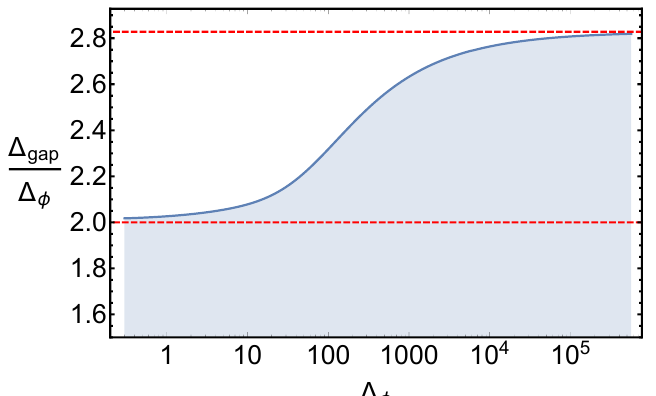
Figure 5 . Gap maximization with 100 components. The curve provides a valid upper bound on the dimension of (cid:30) 2 in D = 1 CFTs. The slope of the bound smoothly interpolates between 2 and 2 As the number of components increases, the transition region is pushed to higher values of (cid:1) (cid:30)